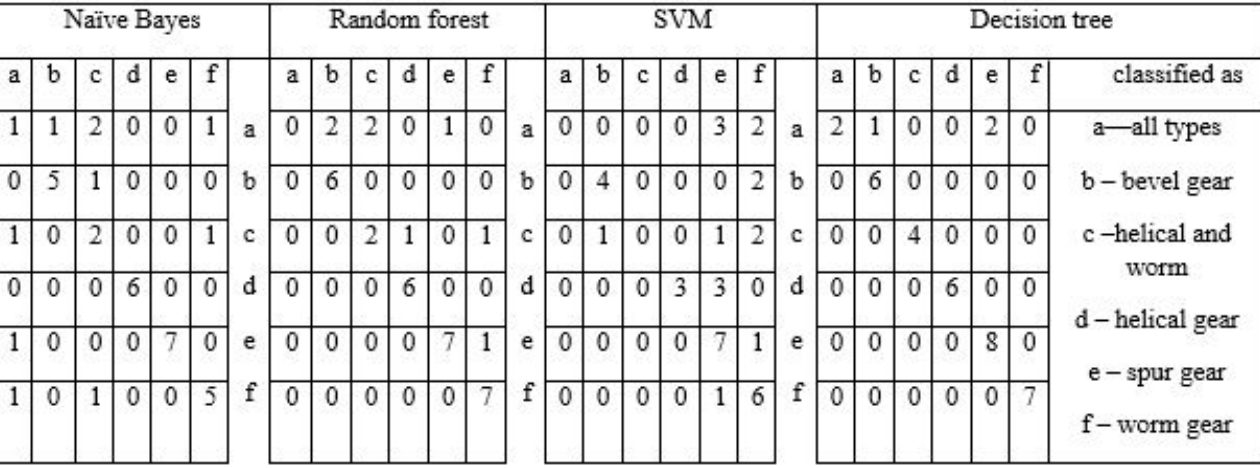
Figure 5. Confusion matrices of Naïve Bayes, Random Forest, SVM, and Decision Trees.